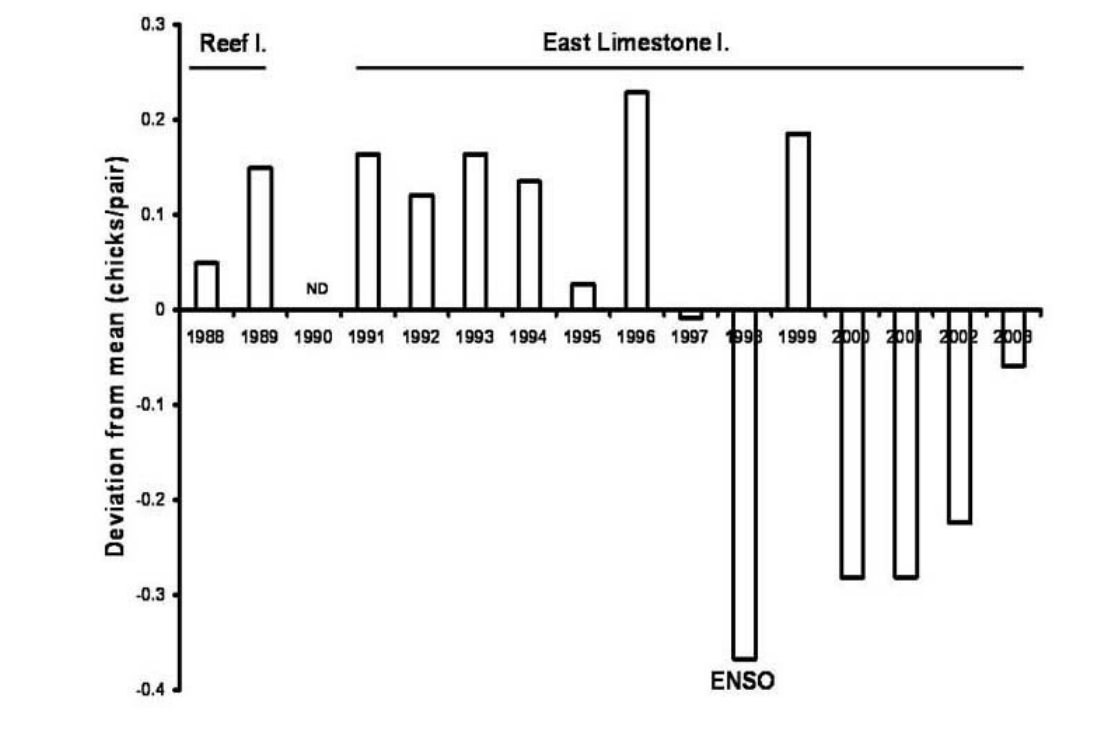
Fig. 3. Deviations from mean annual reproductive success at Reef Island and East Limestone Island during 1988-2003 (data for Reef Island from Gaston